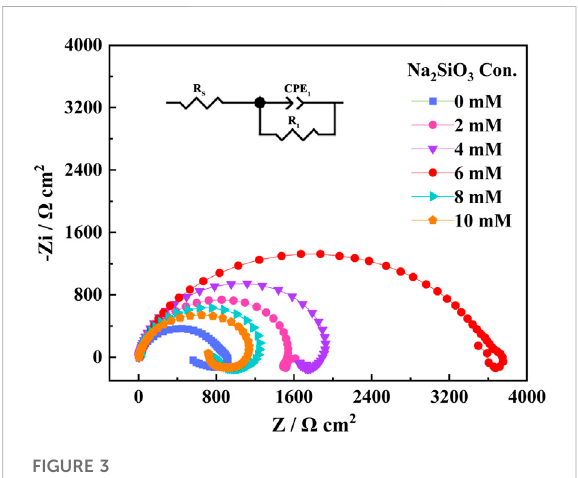
FIGURE 2 DischargecurvesofAZ31B MgalloyelectrodeintheNa 2 SO 4 - NaNO 3 composite electrolyte with different C Na density of 3 mA cm − 2 .